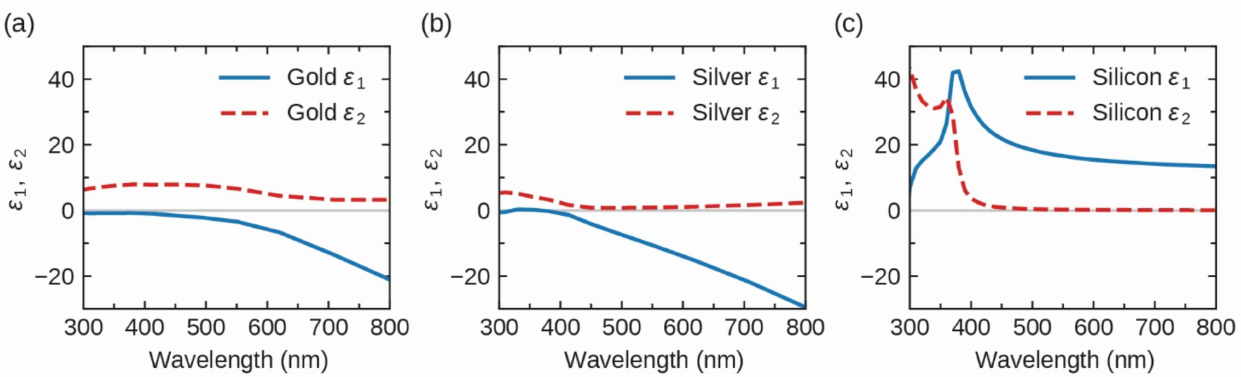
Figure A1. Permittivity of the used gold ( a ) and silver ( b ) adapted from [34]. Permittivity of Si ( c ) adapted from [54] with an interband absorption around 280 nm. Due to the smaller oscillation amplitude compared to Bi 2 Te 3 , ε 1 did not become negative.